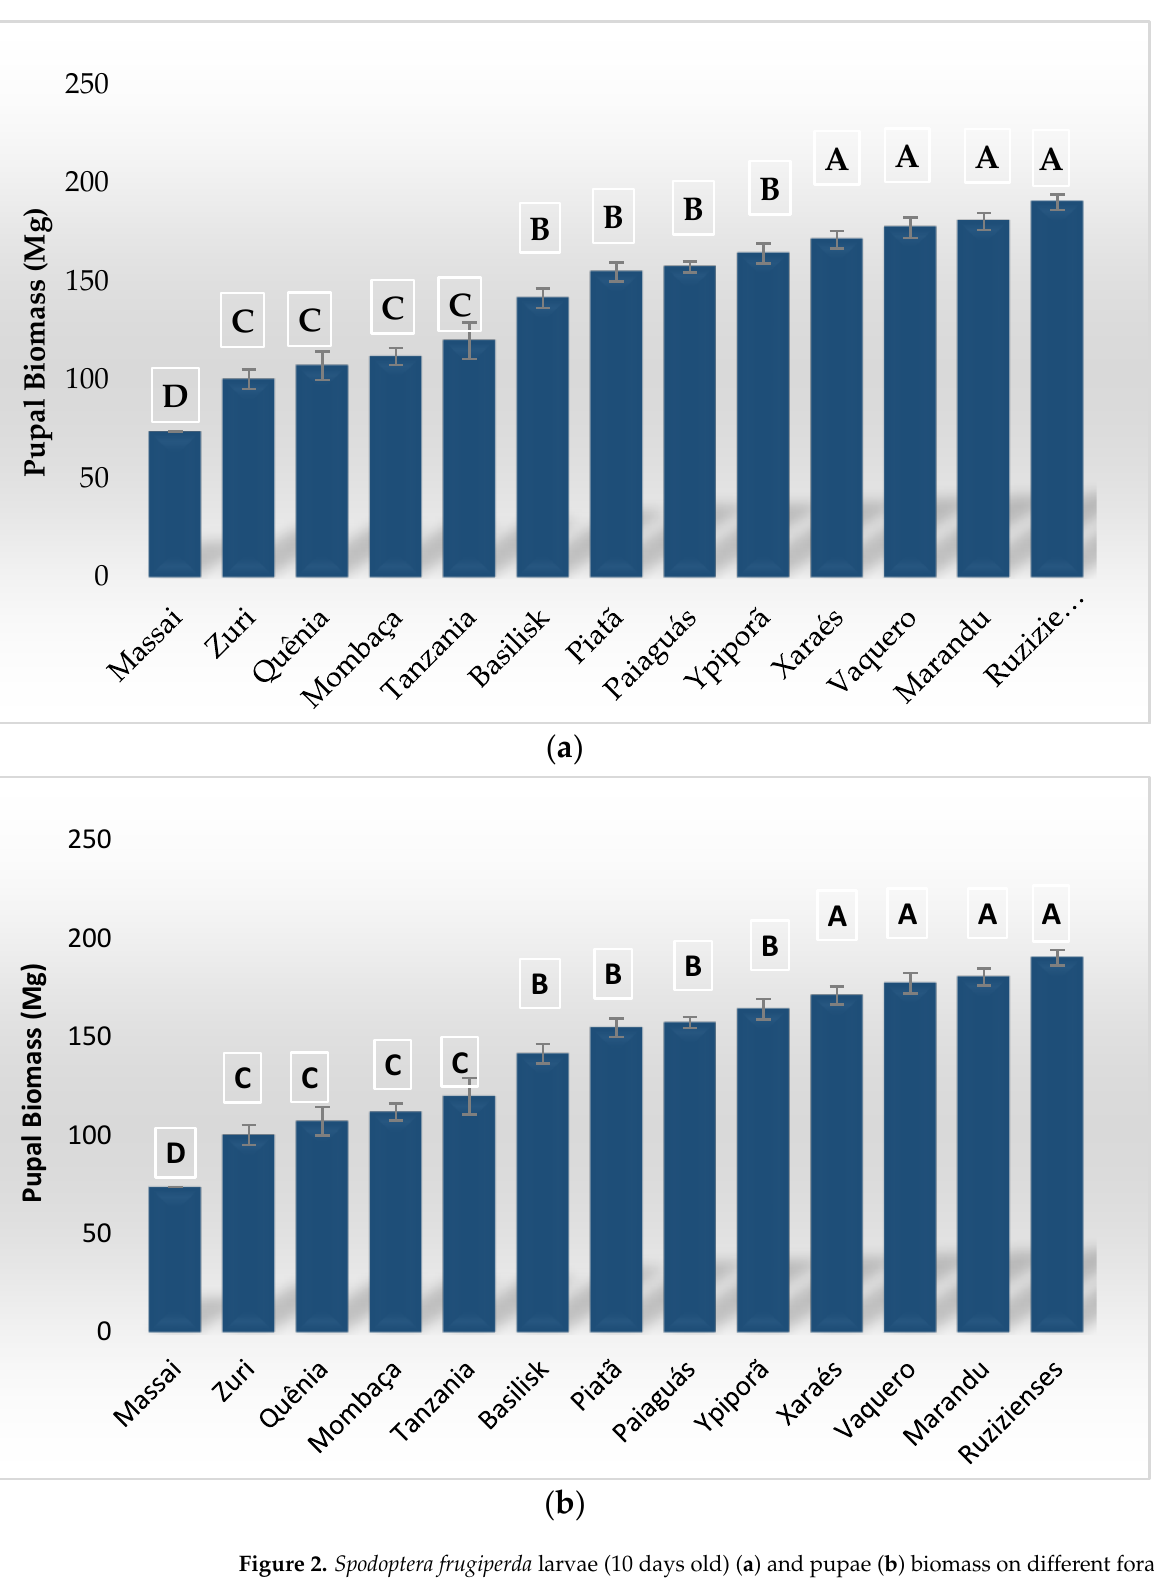
Figure 2. Spodoptera frugiperda larvae (10 days old) ( a ) and pupae ( b ) biomass on different forage and cover crops. Means followed by the same letter do not differ from each other by the Scott–Knott test ( p > 0.05).